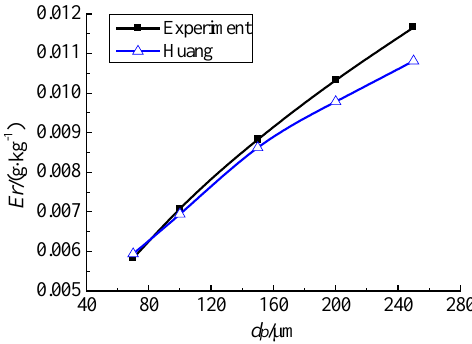
Figure 8. Erosion curve of ash size on SA 210GrA1.